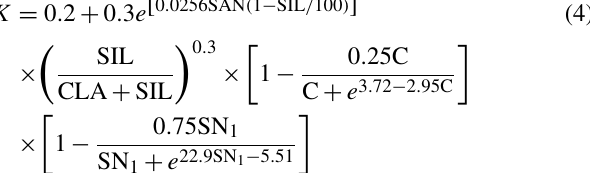
Table 2. Interpolation error of P and I 30 values. RMSE denotes the root mean square